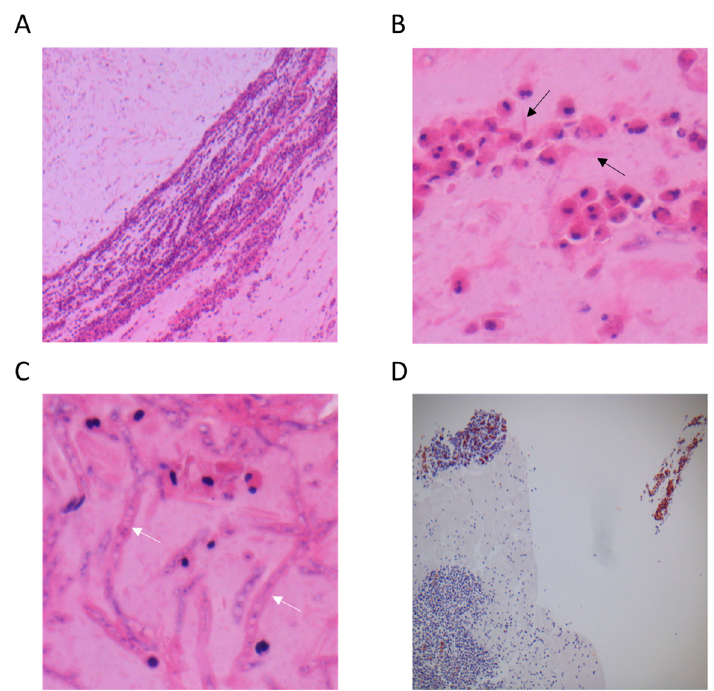
Figure 1. Images from H&E staining of samples obtained by the aspiration of nasal secretions tech- nique. ( A ) A layered aspect of eosinophils aggregated in mucin, and abundant granules (50 × magnification); ( B ) CLC (black arrows) surrounded by granules and necrotic eosinophil cells (400 × magnification); ( C ) Presence of fungal hyphae (400 × magnification); ( D ) Combination of patches of eosinophil and neutrophil cells (10 × magnification).